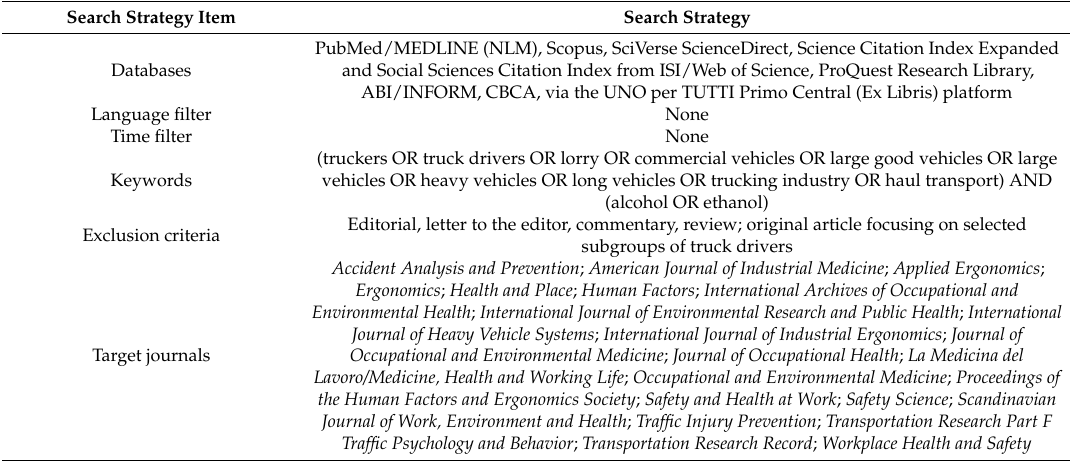
Table 1. Search strategies criteria of the current